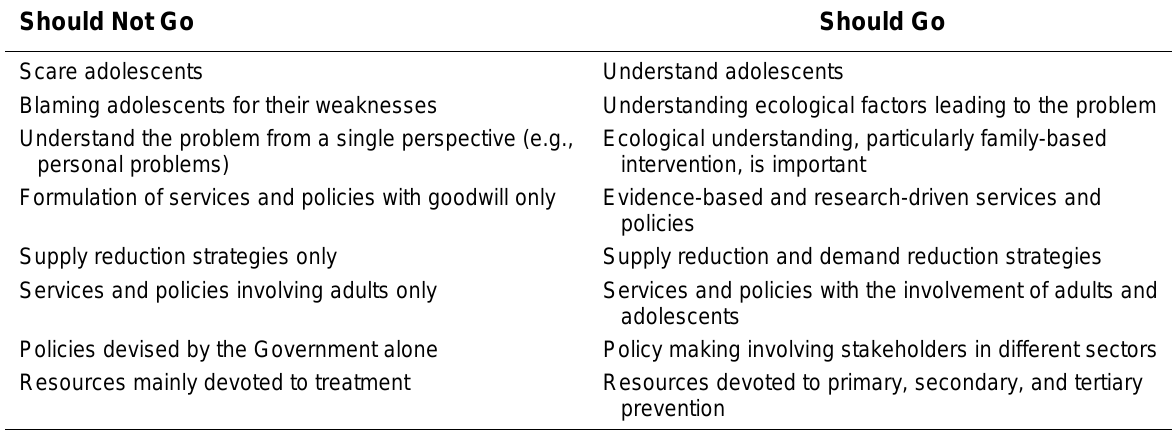
Directions Hong Kong Should Go (and Should Not Go) as Far as Strategies for Tackling Adolescent Substance Abuse are